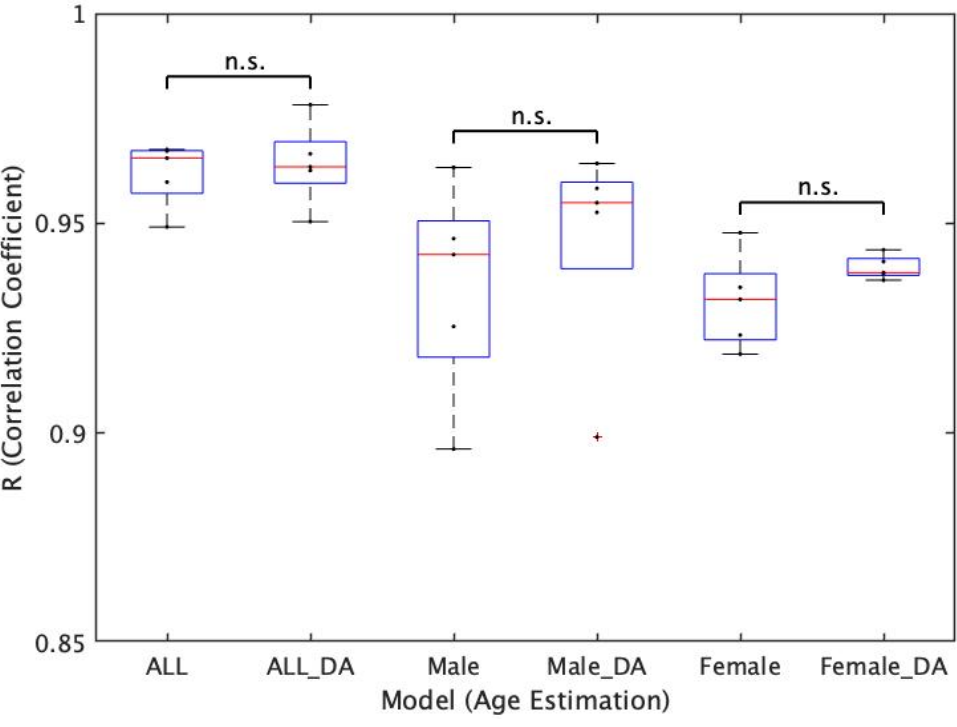
Figure 5. Results for correlation coefficient (R). (DA: Data Augmentation).